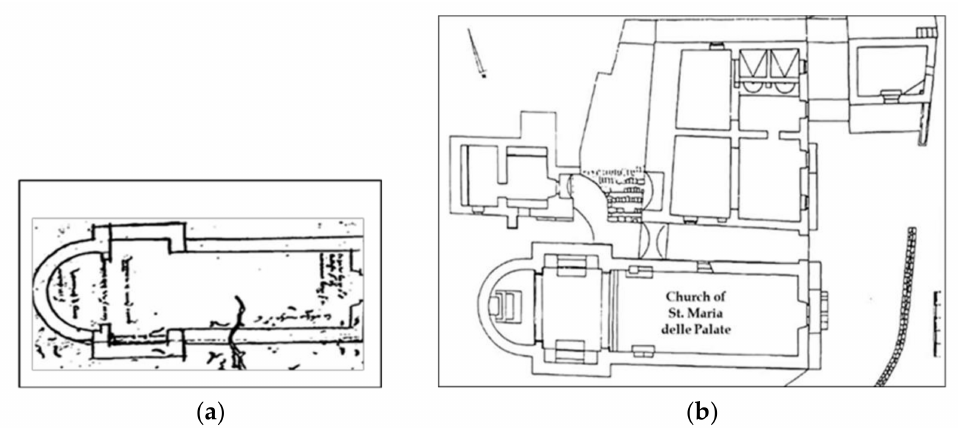
Figure 3. Historical plans: ( a ) plan of the church by Scaluni; ( b ) plan of the church and the adjacent structures by Filangeri, year 1988 [22].